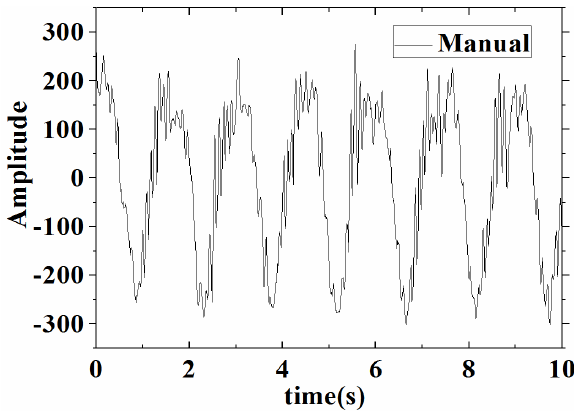
Figure 9. Vibration time domain waveform with manual simulation.